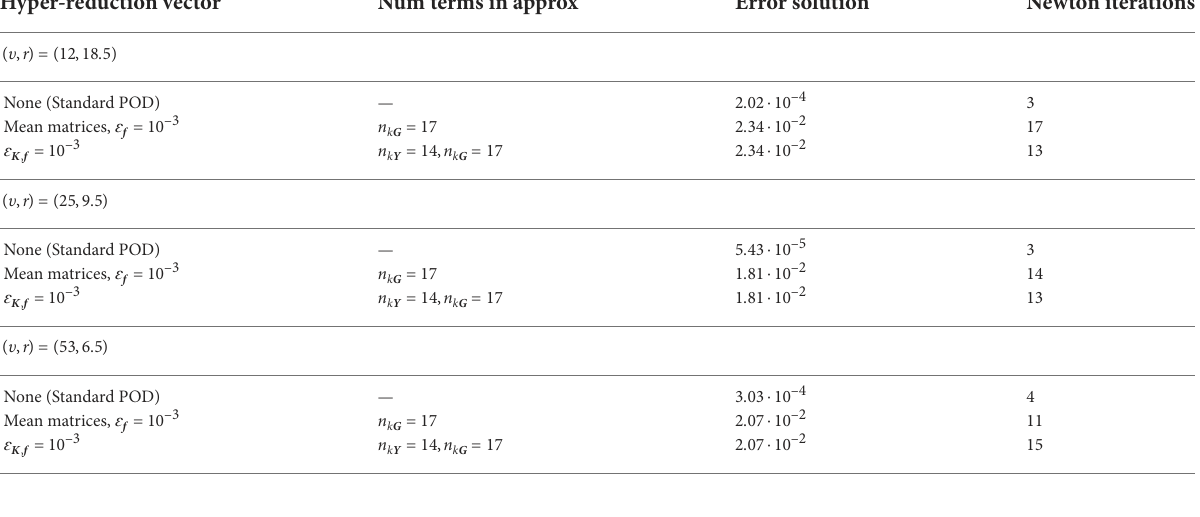
TABLE 3 RelativeerrorsandnumberofNewtoniterationswhenapproximatingthematrixandthevectorinthePODformulationwithhyper-reduction,with tolerance ɛ f forthevectorandmeanmatrices,andtolerance ɛ K , f forapproximatingboththematrixandthevector.Solutionscorrespondingtoparameters ( υ , r ) = ( 12 , 18 . 5 ) ( 25 , 9 . 5 ) and ( 53 , 6 . 5 ) .Trainingsetwith42snapshots. Hyper-reduction vector Num terms in approx Error solution Newton iterations